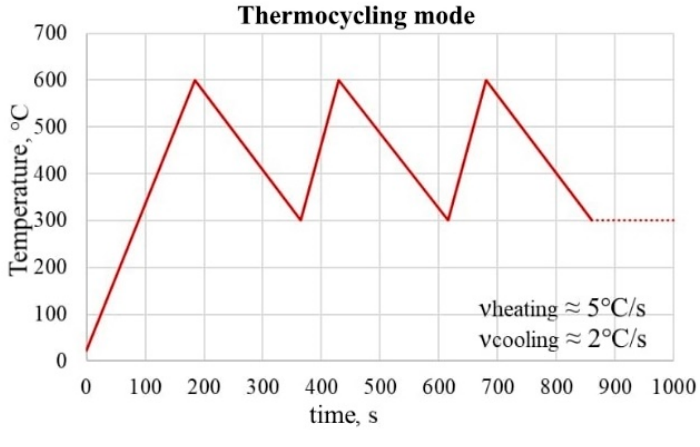
Figure 2. Thermocycling mode.